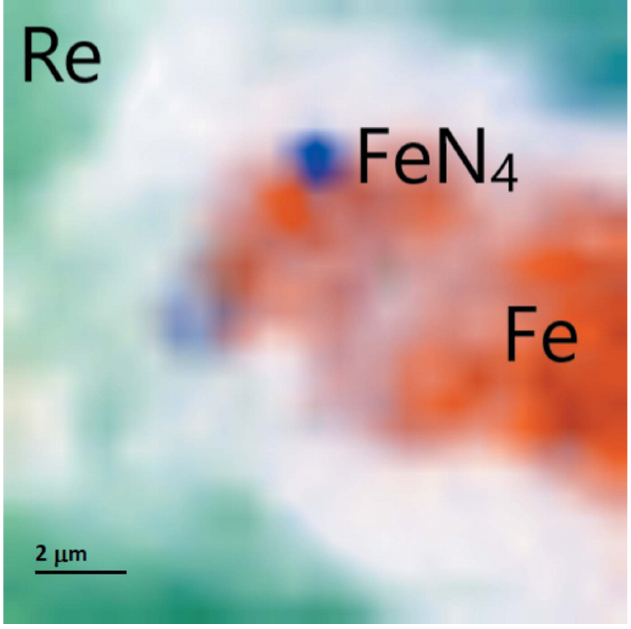
Figure 3 X-ray diffraction imaging of the sample chamber at 180 GPa. The colour intensity is proportional to the intensity of the following reflections: the (100) reflection of Re for the green region; the (101) reflection of Fe for the orange region; the sum of the (101), (111), (0 0 2), and (112) reflections of FeN 4 for the blue